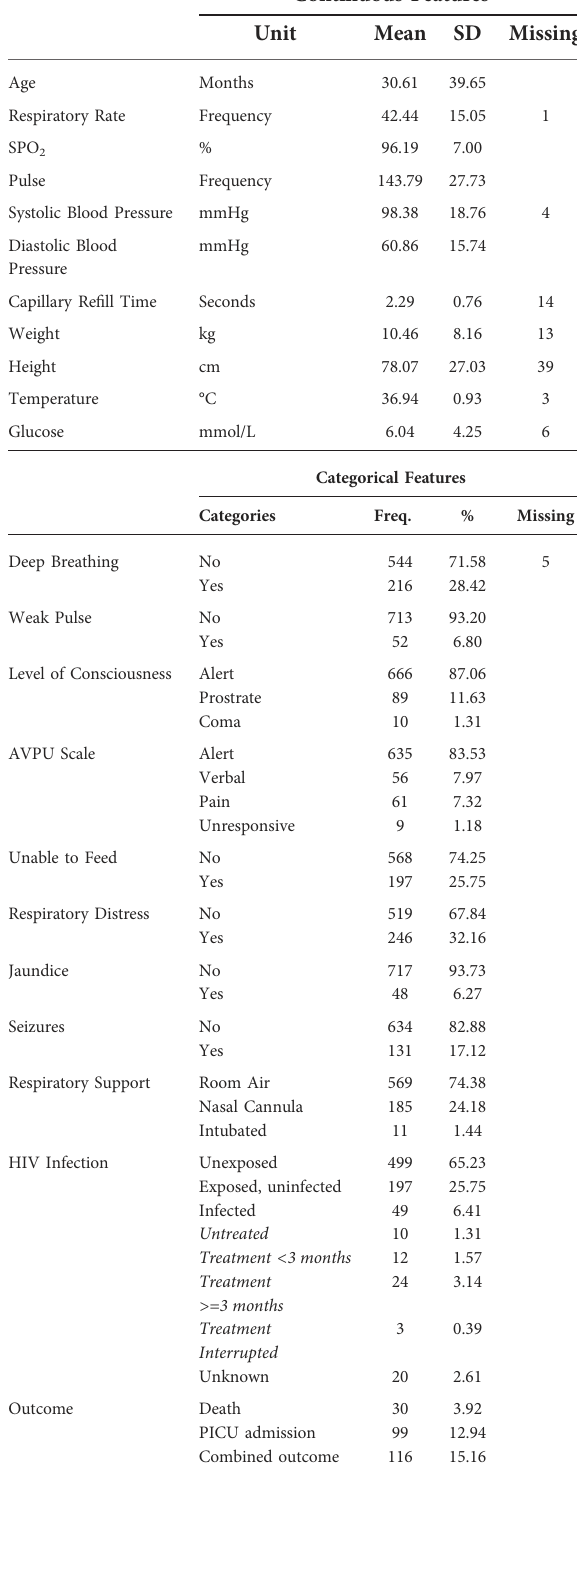
TABLE 3 Descriptive analysis of data